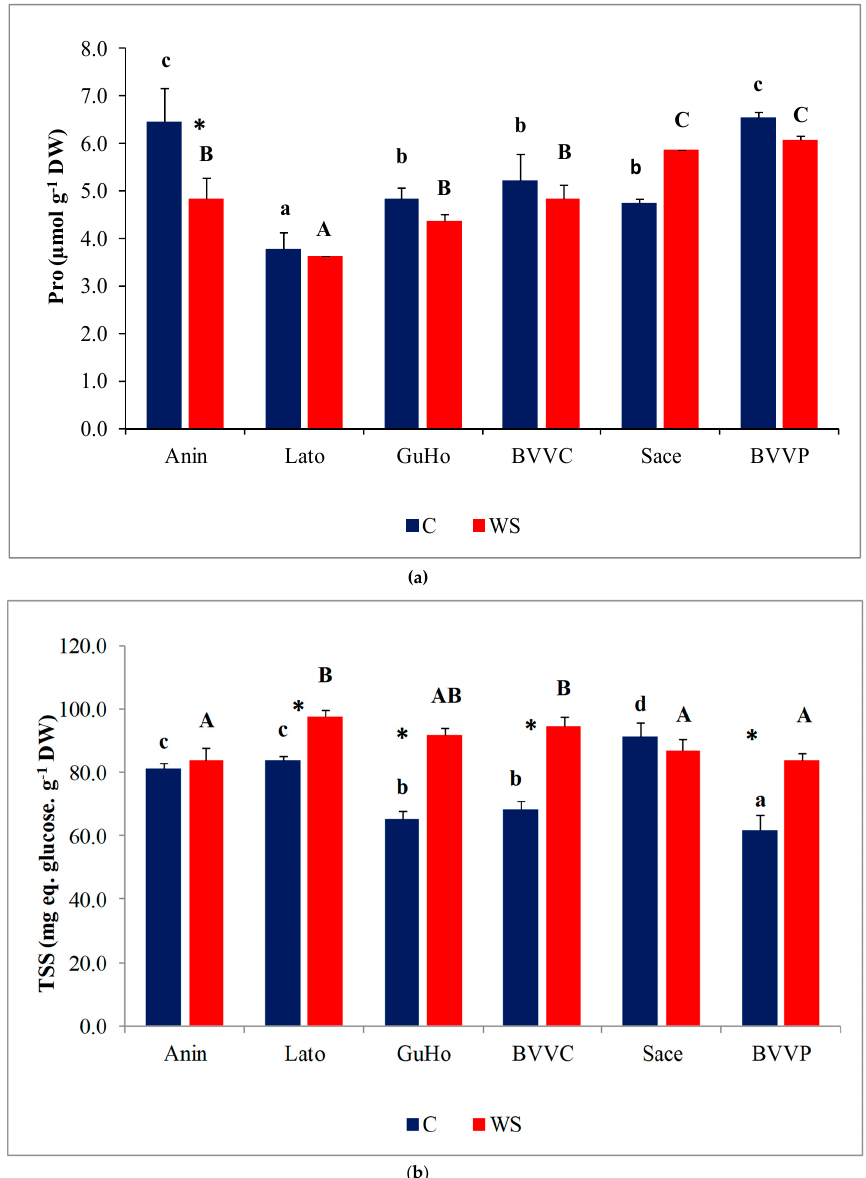
Figure 6. Needles osmolytes contents of six Romanian provenances of L. decidua after one month of applied drought stress (Mean ± SE, n = 5): ( a ) Proline (Pro) expressed in µmol g − 1 DW; ( b ) total soluble sugars (TSS) expressed in mg eq. glucose g − 1 DW. Comparing provenances, different lowercase letters indicate significant differences between control plants, and different uppercase letters indicate significant differences between drought affected plants, according to Tukey’s test ( α = 0.05). Asterisks indicate a significant difference between treatments within the same provenance, according to the LSD value for the interaction ( p = 0.05).